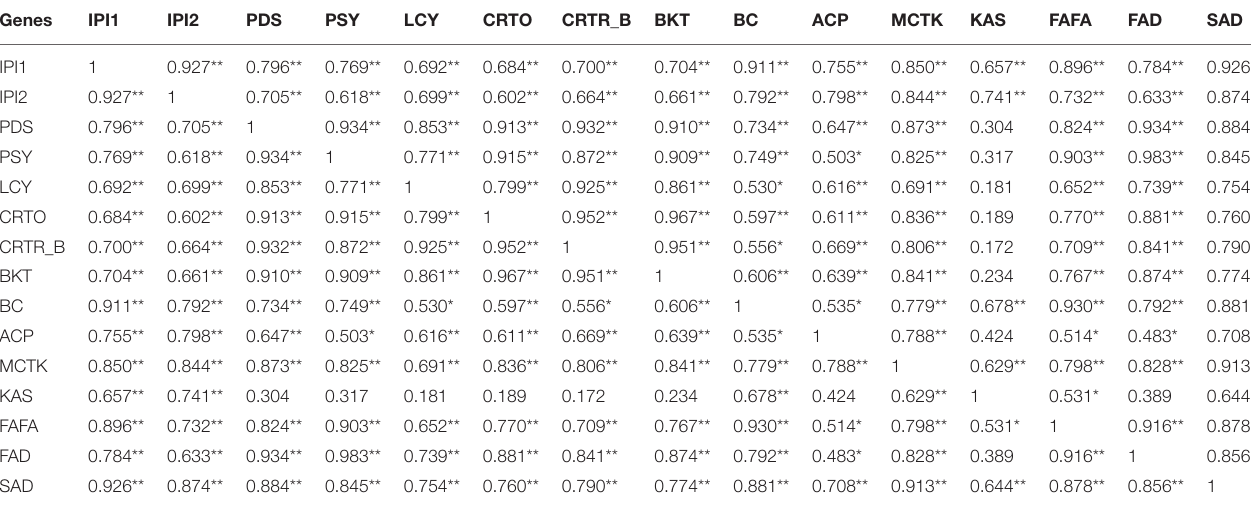
*Indicated that there was a significant correlation between the expression genes at the p < 0.05 level; **Indicated that there was a significant correlation between the expression genes at the p < 0.01 level.